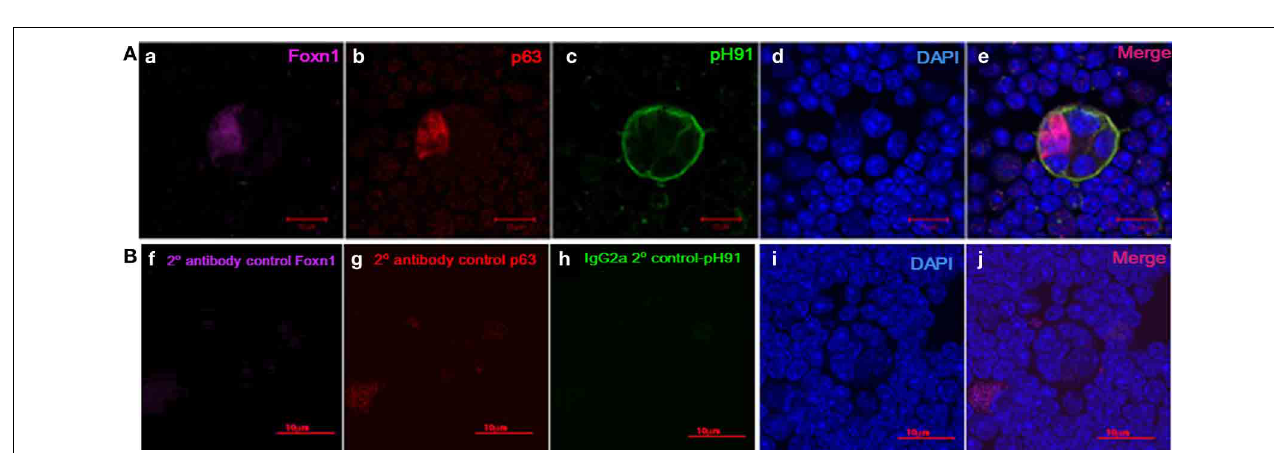
(green) at embryonic stages E13.5, E16.5, E18.5 and 2 weeks after birth respectively. Merged images and inset (B–D) show pH91 + cell expressing p63 (arrow). (E) shows pH91 + cell expressing p63 (arrow) and pH91 + cells that do not express p63 (arrow head). (F) shows the secondary antibody and isotype control for p63 (red) and pH91 (green) respectively.